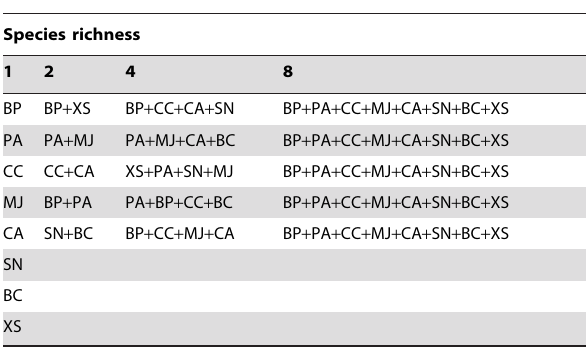
Footnotes: Species abbreviations and their corresponding full names are listed in Table S1.